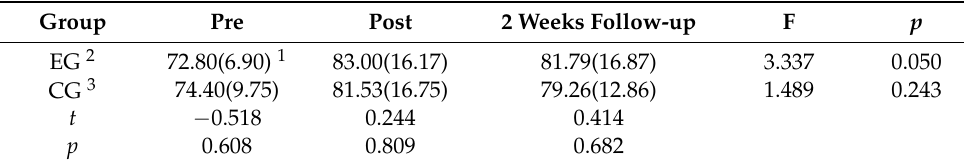
Table 5. Changes in gait velocity by the period. Group